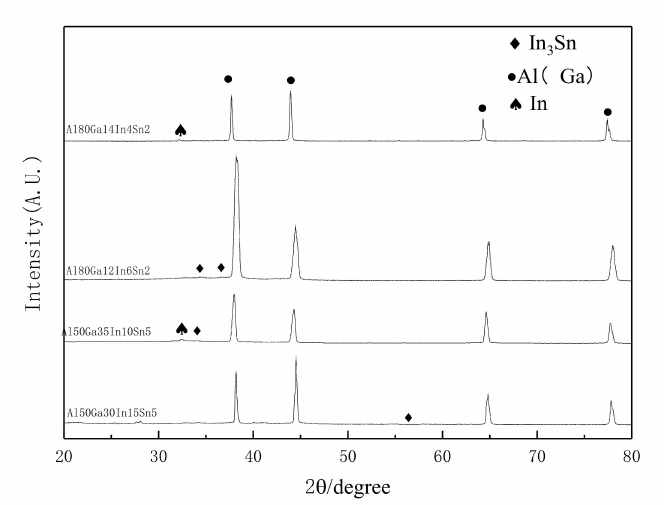
Figure 5. Alloy ingot X-ray diffraction (XRD) with different GIS